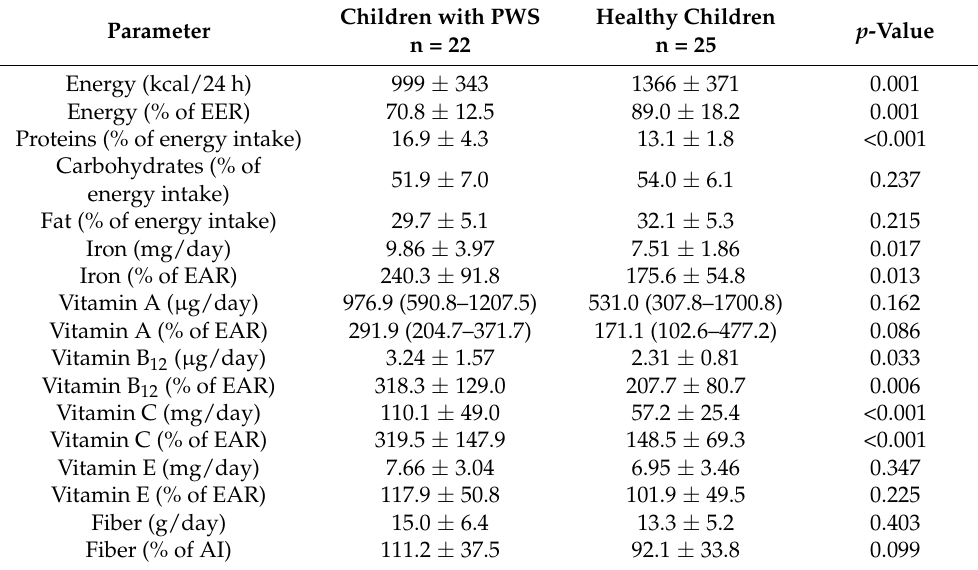
Table 2. Daily energy and nutrient intake of the examined children with PWS and healthy children. Children with PWS Healthy Children p -Value Parameter n = 22 n = 25 Energy (kcal/24 h) 999 ± 343 1366 ± 371 0.001 70.8 ± 12.5 89.0 ± 18.2 Proteins (% of energy